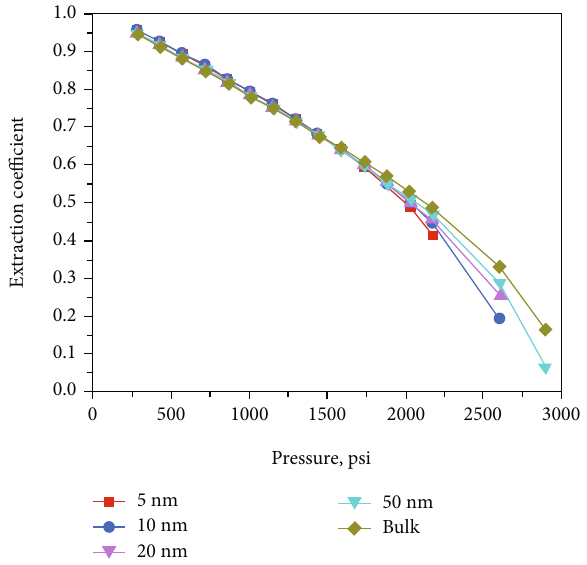
Figure 17: Extraction coe ffi cient of lighter hydrocarbons for the Bakken tight oil versus pressure at various pore radii at T = 230 ° F.